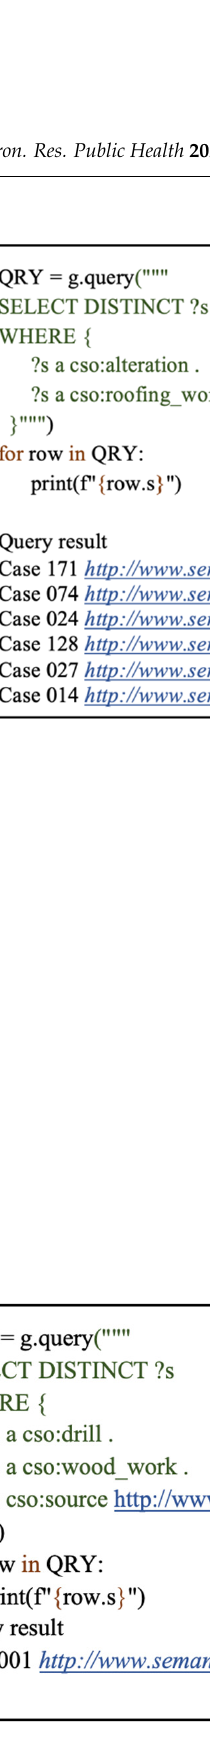
Figure 10. Query 3 code, result, and example of retrieved case.